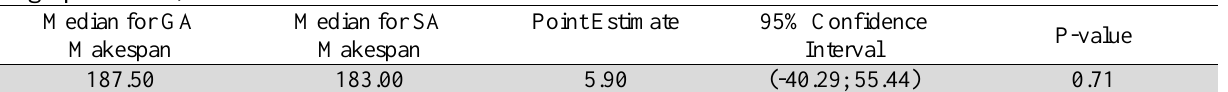
Fig. 5. The results from the test of equal variances for obtained makespan from suggested algorithms (small and large problems)